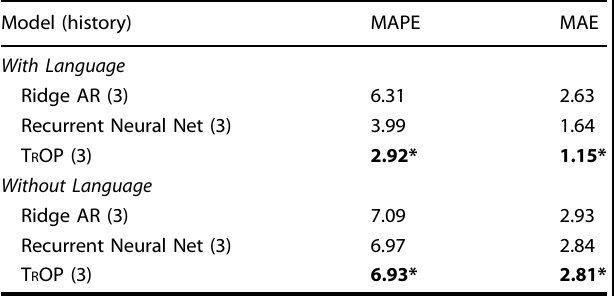
Fig. 4 Model error by Tweets per county. Impact of the number of tweets on error, as measured by deaths per 100k, per county for the test year (2017). The line on the graph is fi t with a LOWESS regression 64 with a shaded region indicating the 95% con fi dence interval. Overall T R OP shows a trend of decreasing error as counties have increasingly more language to build topic representations from. Table 3. Comparison of performance across all of our proposed machine learning models in a univariate context and their ideal history length in the number of years they have access